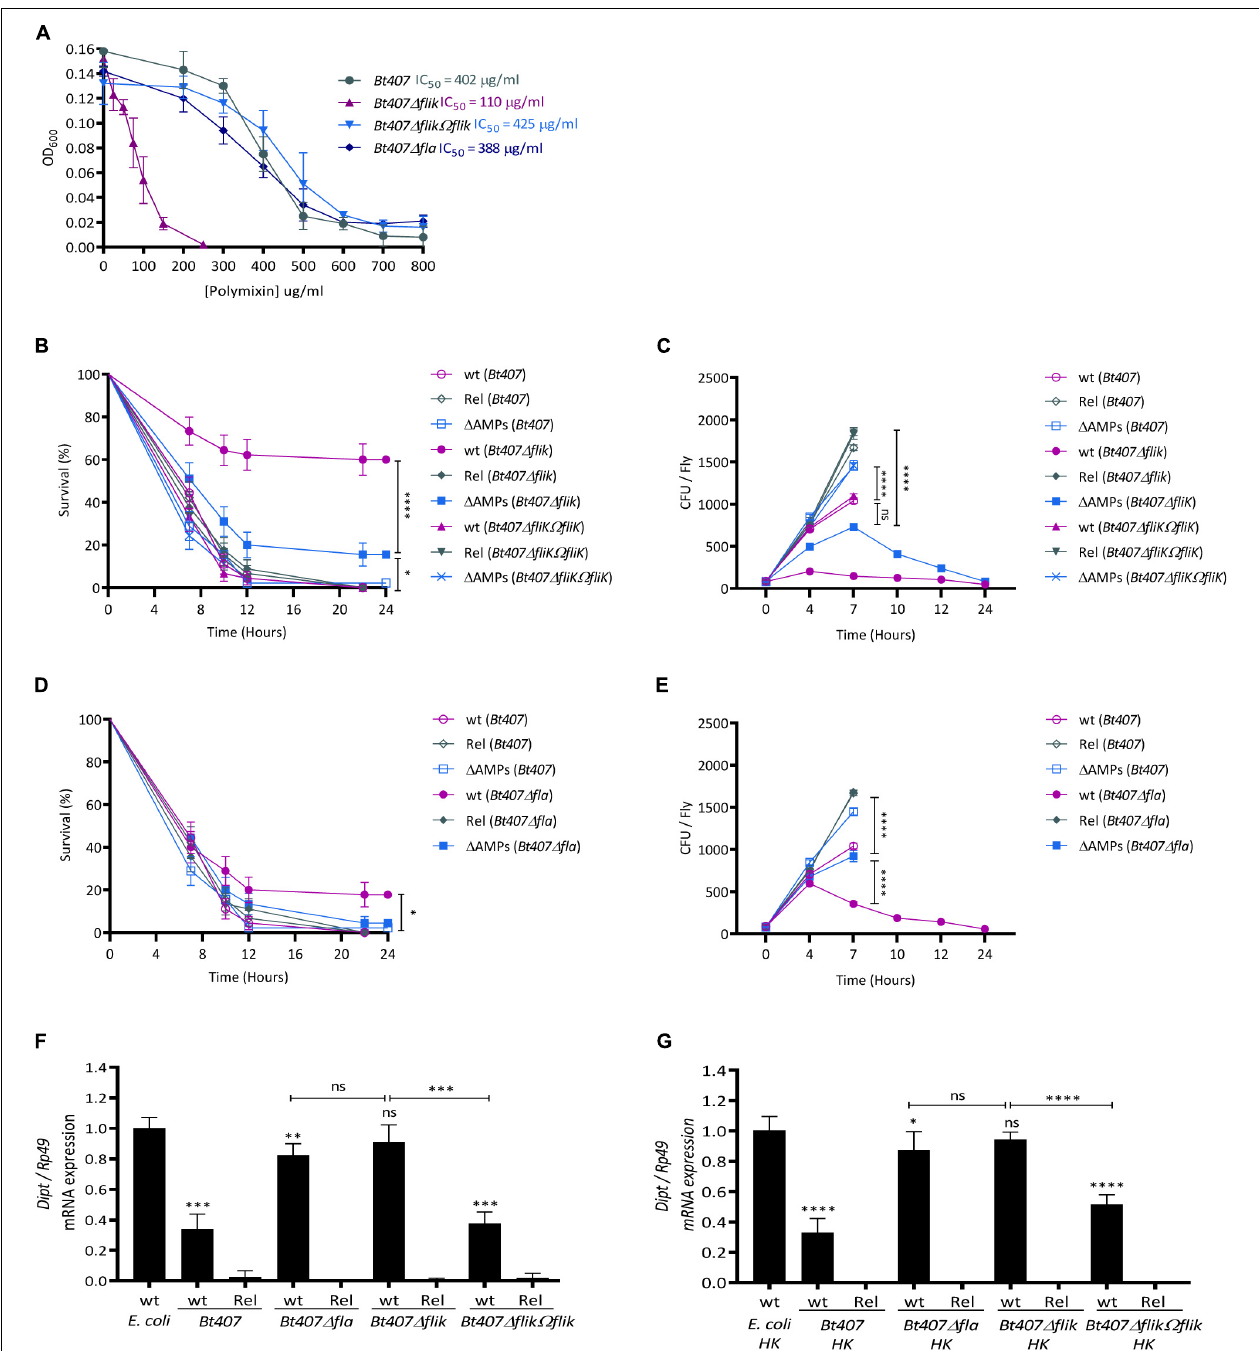
FIGURE 3 | FliK confers Bt407 resistance to Drosophila antimicrobial peptides in a flagella independent manner. (A) The half inhibitory concentration (IC50) of Bt407 , Bt407 (cid:49) fliK , Bt407 (cid:49) fliK (cid:127) fliK, and Bt407 (cid:49) fla . The bacterial growth was scored 6 h post incubation at 30 ◦ C in LB medium supplemented with increased concentrations of polymyxin B. (B,D) Survival of adult wild-type (wt), relish ( Rel ) and antimicrobial peptides ( (cid:49) AMPs ) mutant flies to an infection with Bt407 (B,D) , Bt407 (cid:49) fliK (B) , Bt407 (cid:49) fliK (cid:127) fliK (B) or Bt407 (cid:49) fla (D) . (C,E) Internal bacterial loads retrieved from adult flies infected with Bt407 (C,E) Bt407 (cid:49) fliK (C) , Bt407 (cid:49) fliK (cid:127) fliK (C), or Bt407 (cid:49) fla (E) . The Colony Forming Unit (CFU) counting was performed only on surviving flies. (F,G) Relative expression of the Diptericin ( Dipt ) transcripts in wild-type (wt) or relish ( Rel ) mutant flies induced by living (F) or heat-killed HK (G) Bt407, Bt407 (cid:49) fliK , Bt407 (cid:49) fliK (cid:127) fliK, or Bt407 (cid:49) fla. Transcripts expression was measured by RT-qPCR in total RNA extracts 4 h upon the induction. Ribosomal protein 49 (Rp49) transcript was used as reference gene. Transcripts levels are compared to that triggered in wt flies infected by living (F) or heat-killed HK (G) E. coli as a control. Data obtained from three independent experiments are combined in single value (mean ± SD). Statistical tests were performed using the Log Rank test for the survival assays and Mann-Whitney test for the CFU counting and the Dipt expression evaluation within Prism software (ns: p > 0.05; ∗ 0.01 < p < 0.05; ∗∗ 0.001 < p < 0.01; ∗∗∗ 0.0001 < p < 0.001; ∗∗∗∗ p < 0.0001).